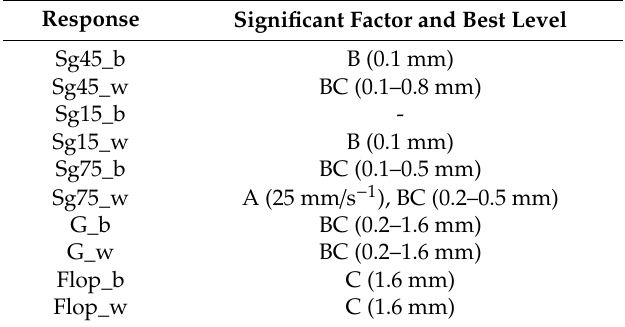
Table 5. The design of experiment (DoE) analysis summary of the PLA samples.